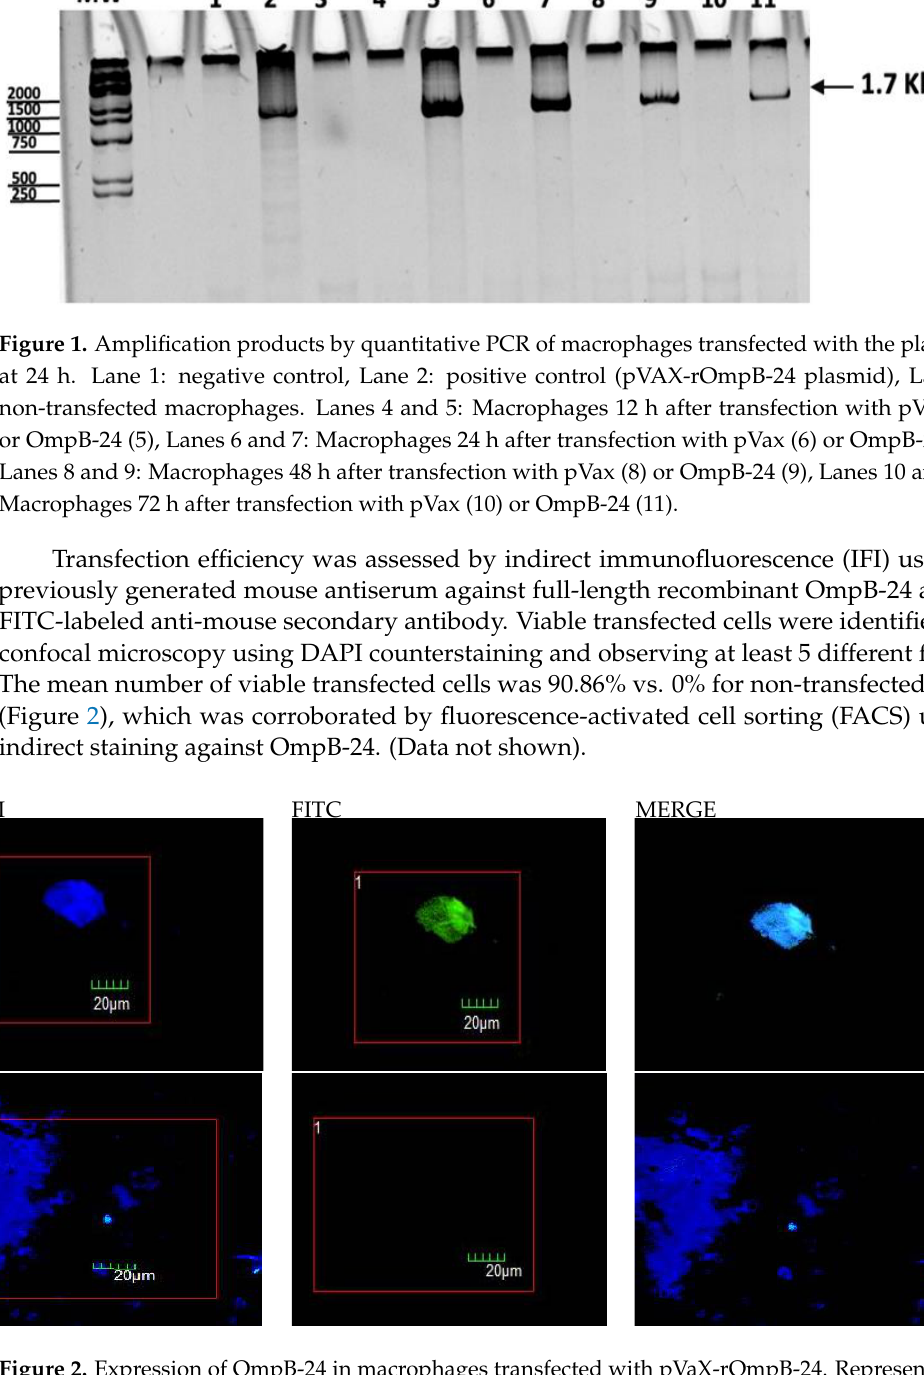
Figure 2. Expression of OmpB-24 in macrophages transfected with pVaX-rOmpB-24. Representative images obtained by confocal microscopy of a single macrophage (20 µm) 24 h after transfection are shown, including ( A ) OmpB-24 immune serum and ( B ) Preimmune serum. Staining for viability (DAPI) and OmpB-24 expression (FITC) are shown in the merge row. image was observed at 40× (LSMC FV-1000, Olympus, Tokyo, Japan).